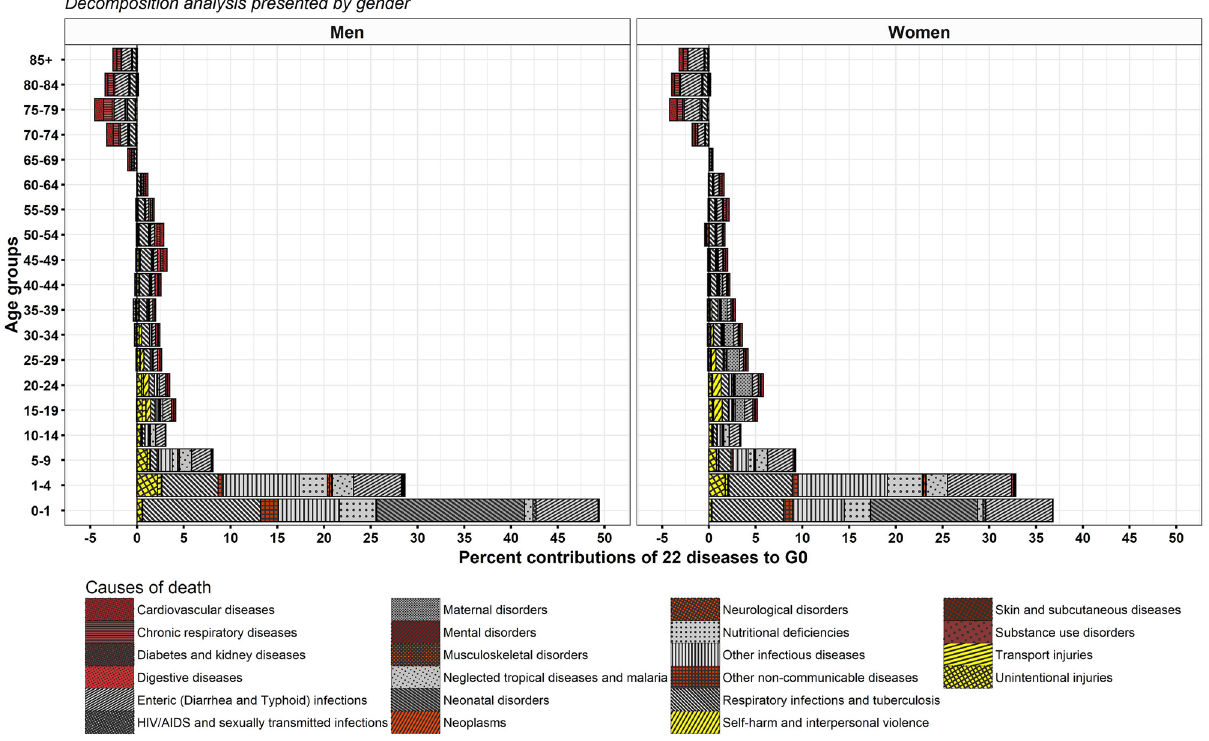
Figure 8. Age-cause-specific contributions to ΔG 0 , men and women, between 1990–1994 and transmitted diseases 61 together with that of respiratory infections and tuberculosis and enteric infections. Enteric infections and respiratory infections and tuberculosis also show considerable contributions to Δe 0 and ΔG 0 at middle and old ages (Figs. 7 and 9). However, many NCDs at middle through old ages contribute considerably to Δe 0 but negligibly to ΔG 0 . The disparateness in the age-specific contributions to Δe 0 (Figs. 6 and 7) and ΔG 0 (Figs. 8 and 9) by CDs and NCDs at middle and old ages highlights the contrasts for a shift in e 0 versus transformation in age at death as measured by G 0 . The mortality decline for CDs at infant through old ages showed a shift in e 0 as well as reshaped the distribu- tion of age at death; however, the mortality decline for NCDs at middle and old ages trivially corroborated the shift in e 0 but importantly didn’t contribute to the transformation in age at death or its dispersion (G 0 ) (Figs. 6, 7, 8, and 9). A negligible contribution to ΔG 0 by NCDs at middle through old ages was on the account of its disequalising contributions. By the virtue of equalising (positive) and disequalising (negative) effects on G 0 , the NCDs and CDs showing affirmative contributions before the threshold age, however, do not contribute for a better G 0 after that threshold age 17,62 (Figs. 8 and 9). The low threshold age in 65–69 years 62 is critical for India (Fig. 9) because a possibility of reduction in premature deaths is restrained by a narrow age-interval. On the other hand, a wide age-interval at middle through old ages burdened with NCDs as well as CDs allows for high disparity in lifespan. Thus, a low threshold age puts major constraints for possible affirmative age-specific contributions from NCDs emplaced at middle and old ages. The same is also applicable for CDs, however, given their preponderance at infant through old ages they do have large reduction in the burden at younger ages that compensates for disequalising contribu- tions in old ages. Such changes in mortality rates by age and variations in causes of death has a repercussion on the age pattern of mortality. While there are significant changes in the mortality rates and variations in cause of death over time in the infant, child, and adult age groups; however, the same is modest in middle through old ages which is also evident in terms of modest mortality deceleration at old ages over time 42,63 . As a consequence, the pattern of age-specific contributions has remained more or less unchanged and a modest structural change in causes of death is witnessed in India. On the other hand, developed countries such as Japan, Sweden, Switzerland, Singapore, Australia, Germany, Russia, the USA, and other developed countries show significant changes in the pattern of age-specific contri- butions as well as causes of death structure, and importantly high causes-of-death variation 23,64–66 . Bergeron- Boucher et al. 13 for low-mortality countries demonstrate significant rise in cause-of-death variation, measured by entropy, since the early 1990s. Yoshinaga and Une 67 for Japan demonstrate dramatic changes in the cause of death structure from the dominance of tuberculosis and pneumonia until the 1960s to cerebrovascular diseases between 1970 and 1990s, and heart diseases other than ischemic heart disease since 2000s, along with shift in the major contributing age group, i.e. from 0–4 years to 75–84 years. Japan manifests changes in causes of death structure many times and swift changes in the pattern of age-specific contributions to gain one of the highest e 0 in the world. Denmark show a significant change in the contribution of middle age group which was negligible during